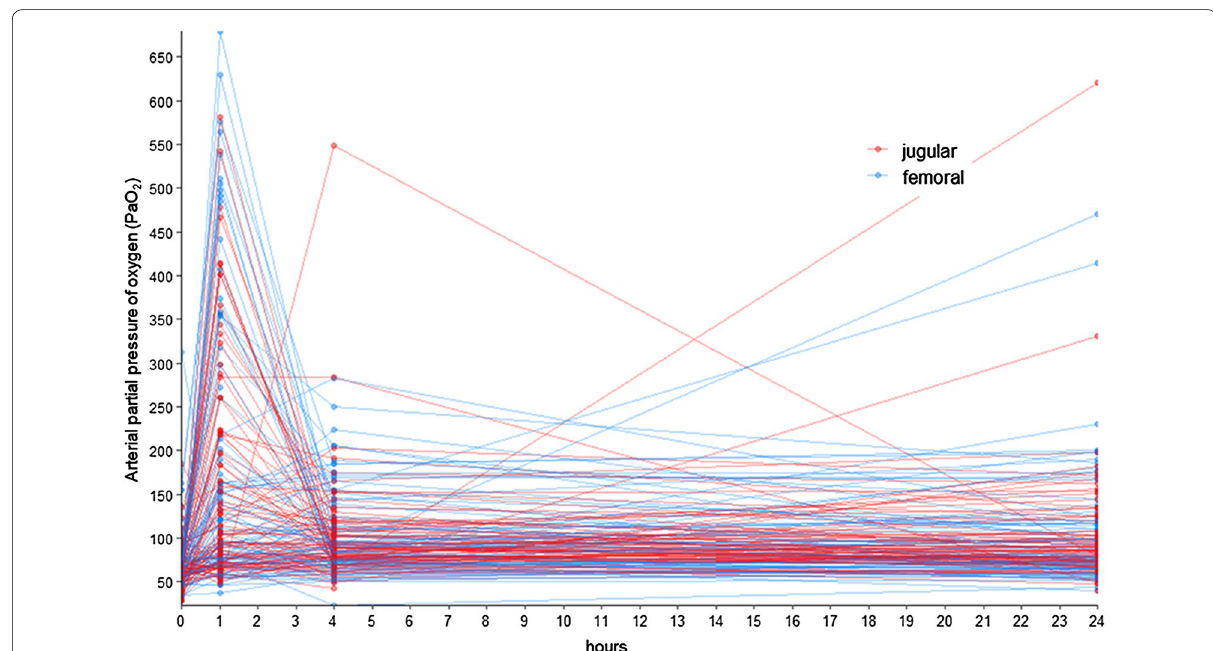
Fig. 1 Change in the arterial partial pressure of oxygen (PaO 2 ) during ECMO based on cannula configuration. Red line indicating jugular group in which return cannula site of VV‑ECMO is femoral vein. Blue line depicting femoral group in which return cannula site of VV‑ECMO is internal jugular